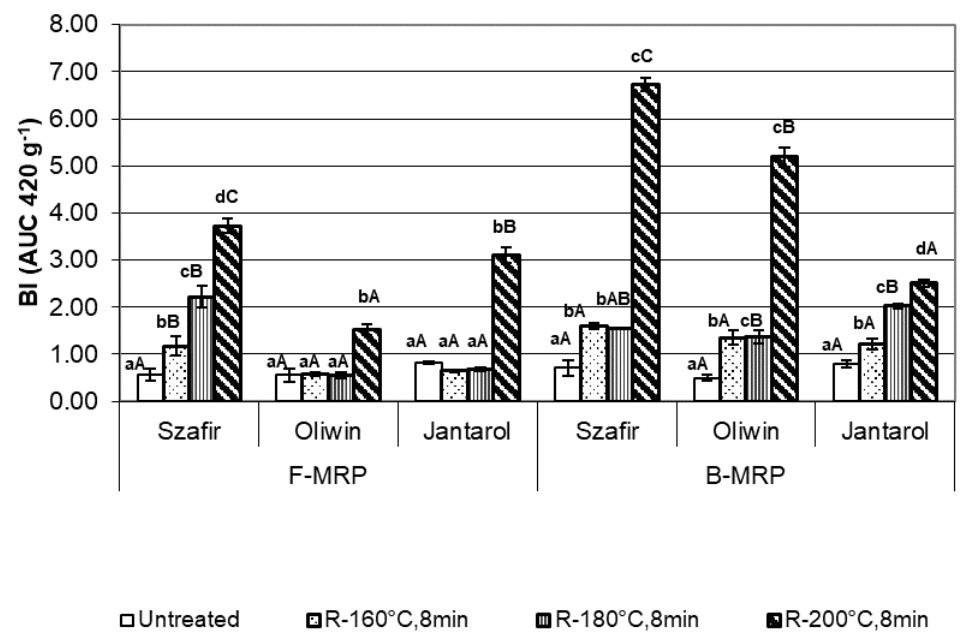
Figure 2. Free (F-MPR) and bound-to-protein (B-MPR) Maillard reaction products of the untreated